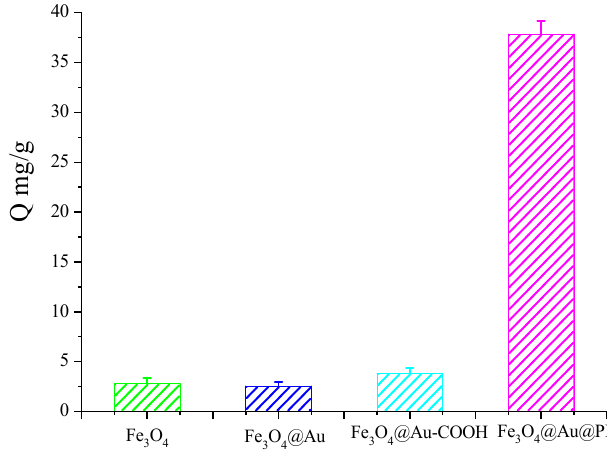
Figure 6. Adsorption mass of Cu(II) on different magnetic nanomaterials. V = 1.0 mL, m = 3.0 mg, C i = 10.0 mmol/L, time 2 h, temperature RT.